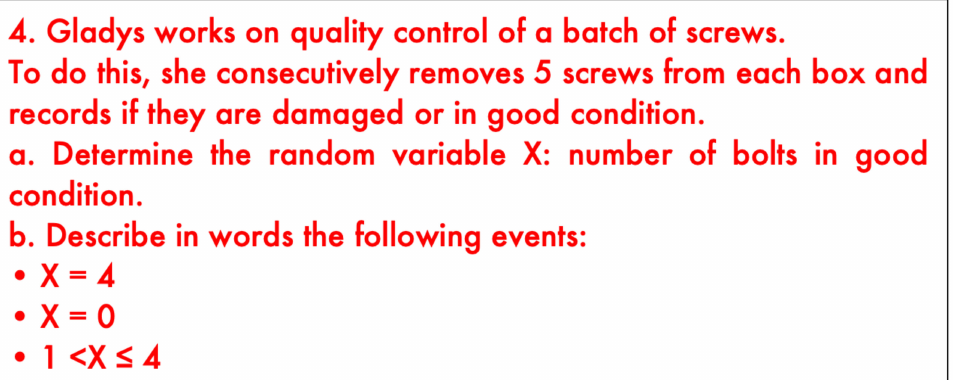
Figure 12. Example of task group 2: symbolic–verbal (Adapted from [34] (p.